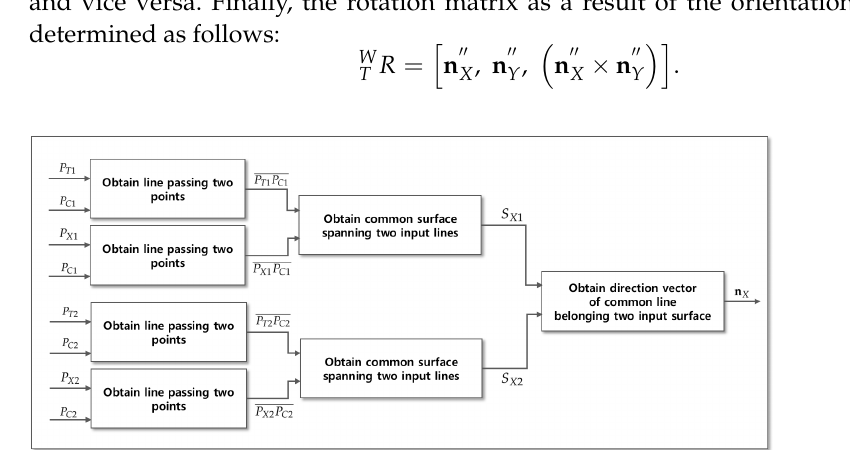
Figure 7. Estimation process for the approach vector of an orientation matrix.